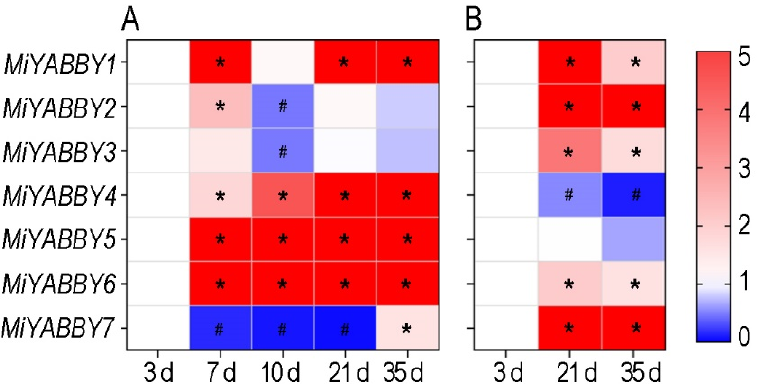
Figure 3. Relative expression analysis of the MiYABBY gene family in different mango organs. ( A ) shows the results from different leaves, and ( B ) shows the results of different fruits. The calculation method was 2 −∆∆ CT , and ‘*’ means the value exceeds 1.5, whereas ‘#’ means the value is below 0.5.